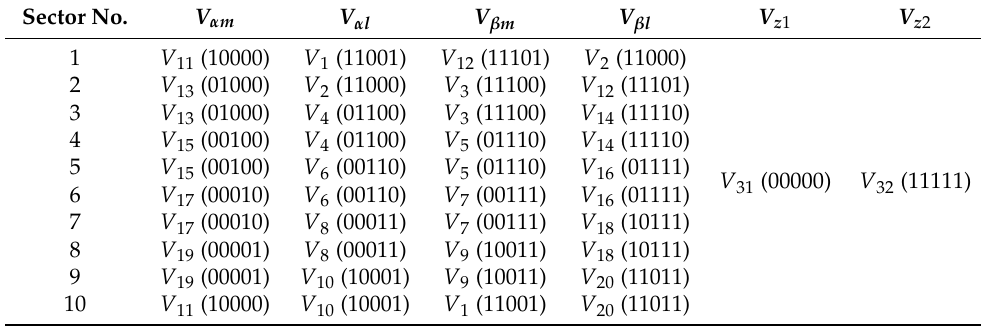
Table 2. Switching vectors for the inverter at different sectors to minimize switching losses. Sector